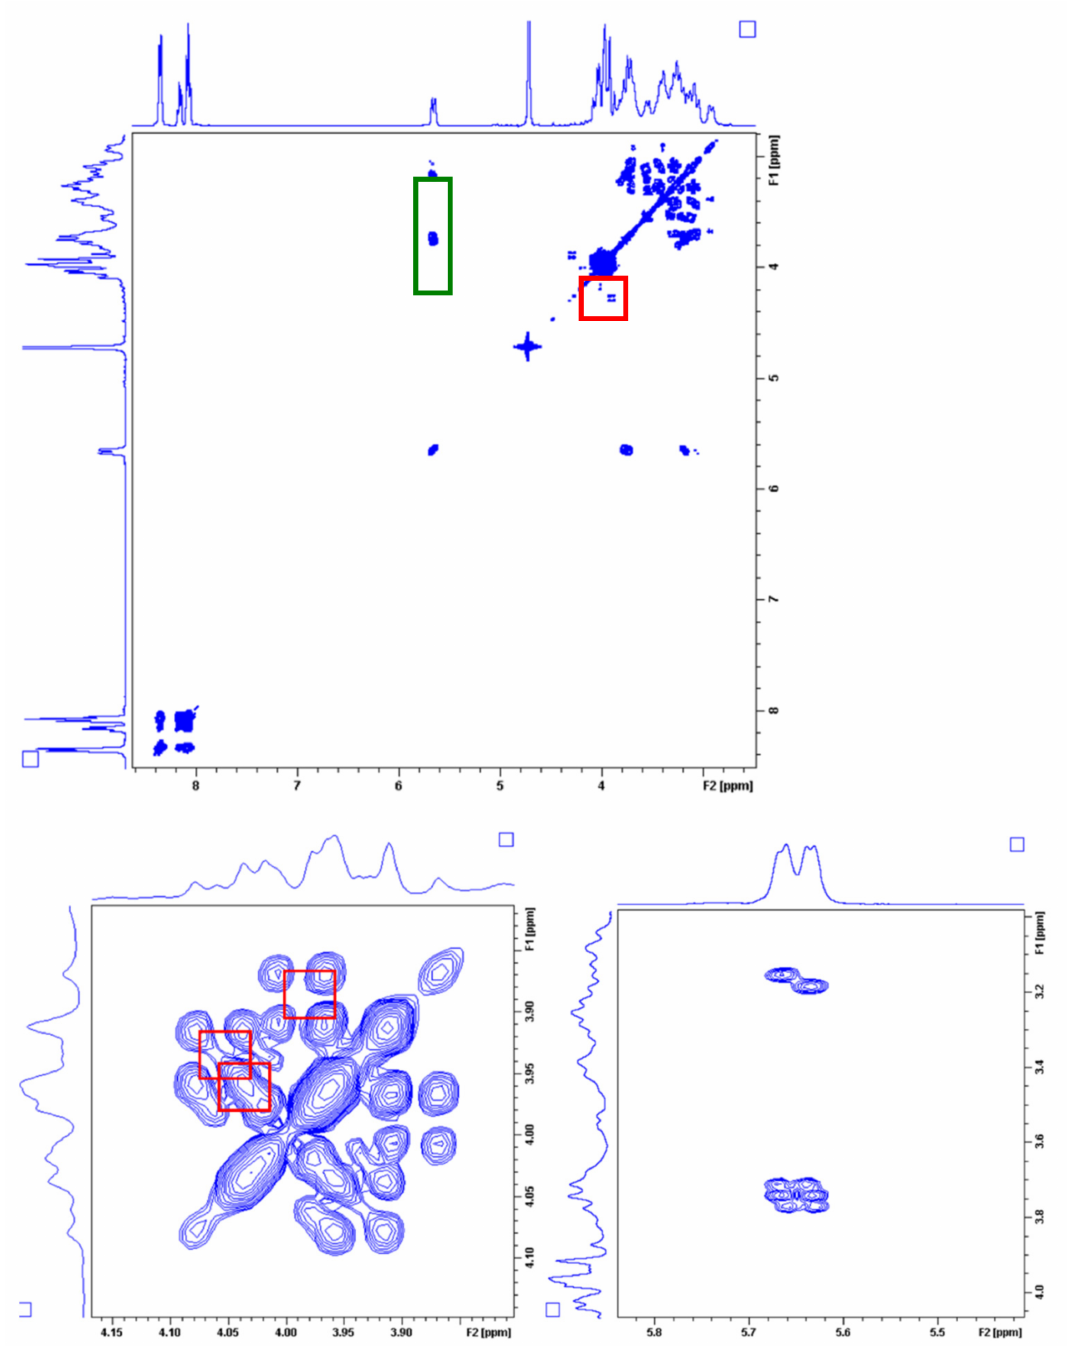
Figure 7. 1 H 2D COSY spectrum of Y(DO3A-BACE) − in D 2 O at 80 ◦ C ( top ) and two expansions ( bottom ): A2, A3, and A4 arm protons are in the left, while the cross peaks between A1s and A1ab protons are in the